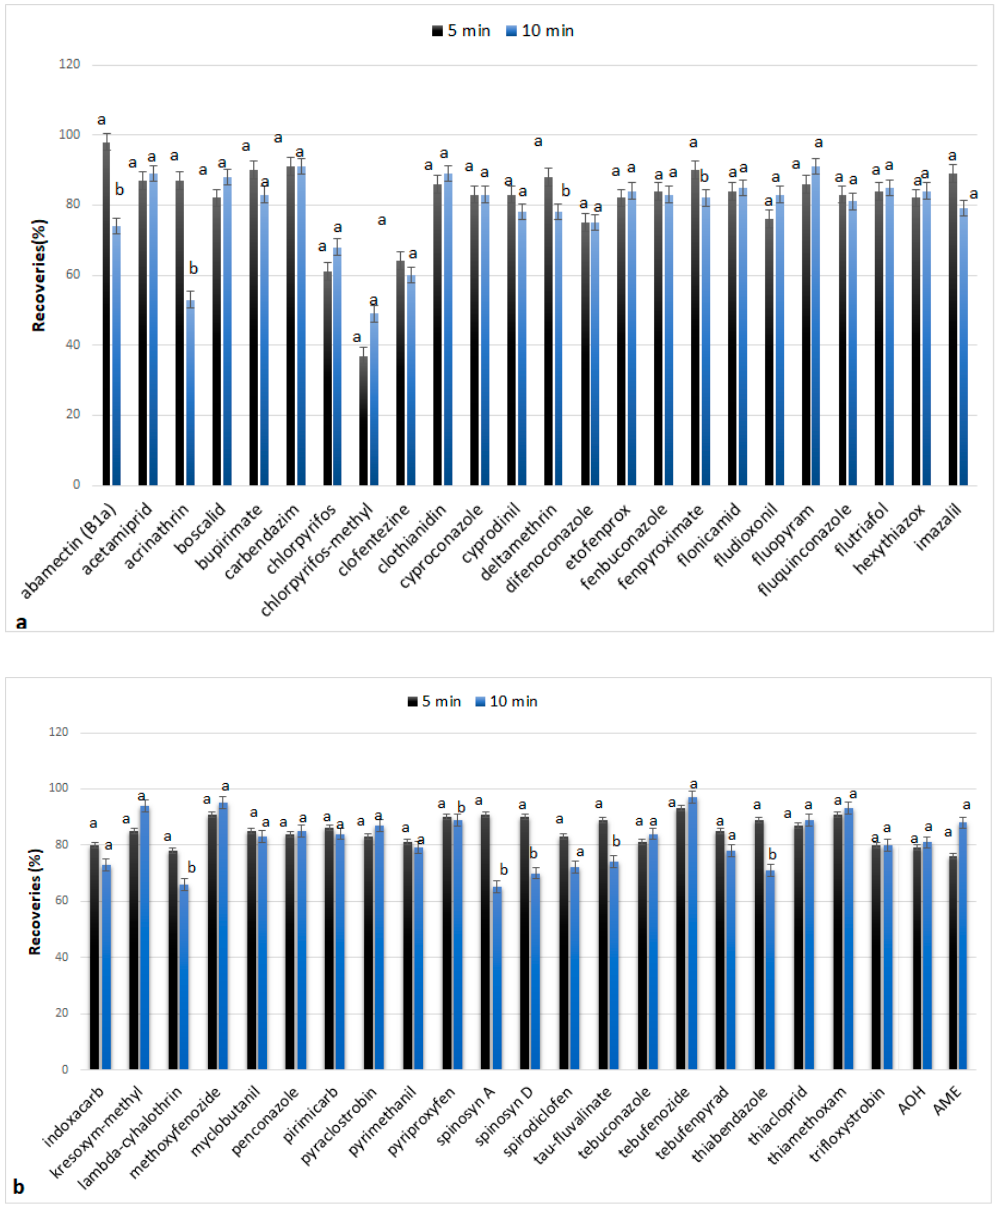
Figure 4. Recoveries (%) of analytes when MAE extraction was carried out for 5 and 10 min: ( a ) abamectin (B1a), acetamiprid, acrimathrin, boscalid, bupirimate, carbendazim, chlorpyrifos, chlorpyrifos-methyl, clofentezine, clothianidin, cyproconazole, cyprodinil, deltamethrin, difenoconazole, etofenprox, fenbuconazole, fenpyroximate, flonicamid, fludioxonil, fluopyram, fluquinconazole, flutriafol, hexythiazox, imazalil; ( b ) indoxacarb, kresoxym-methyl, lambda-cyhalothrin, methoxyfenozide, myclobutanil, penconazole, primicarb, pyraclostrobin, pyrimethanil, pyriproxyfen, spinosyn A, spinosyn D, spirodiclofen, tau-fluvalinate, tebuconazole, tebufenozide, tebufenpyrad, thiabendazole, thiacloprid, thiamethoxam, trifloxystrobin, alternariol (AOH), alternariol monomethyl ether (AME). The values for each substance followed by the same letter do not differ significantly statistically ( p < 0.05).